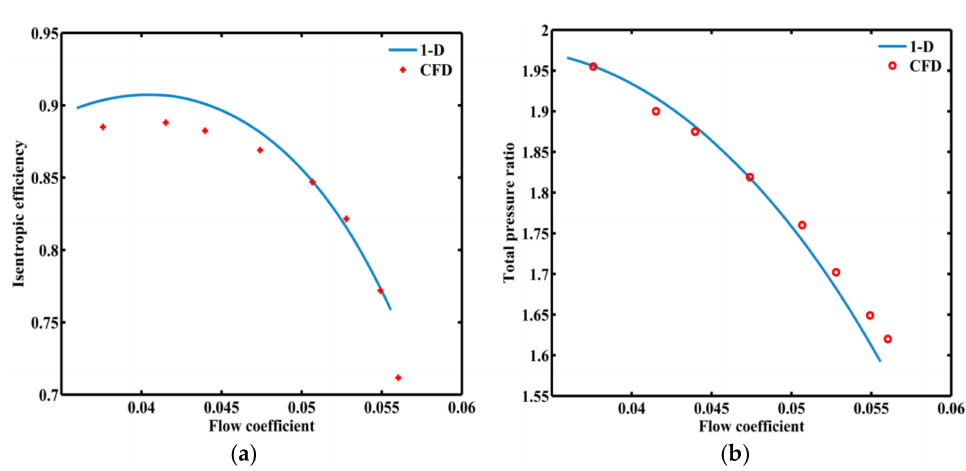
Figure 12. Grid of the compressor (10 MWe).